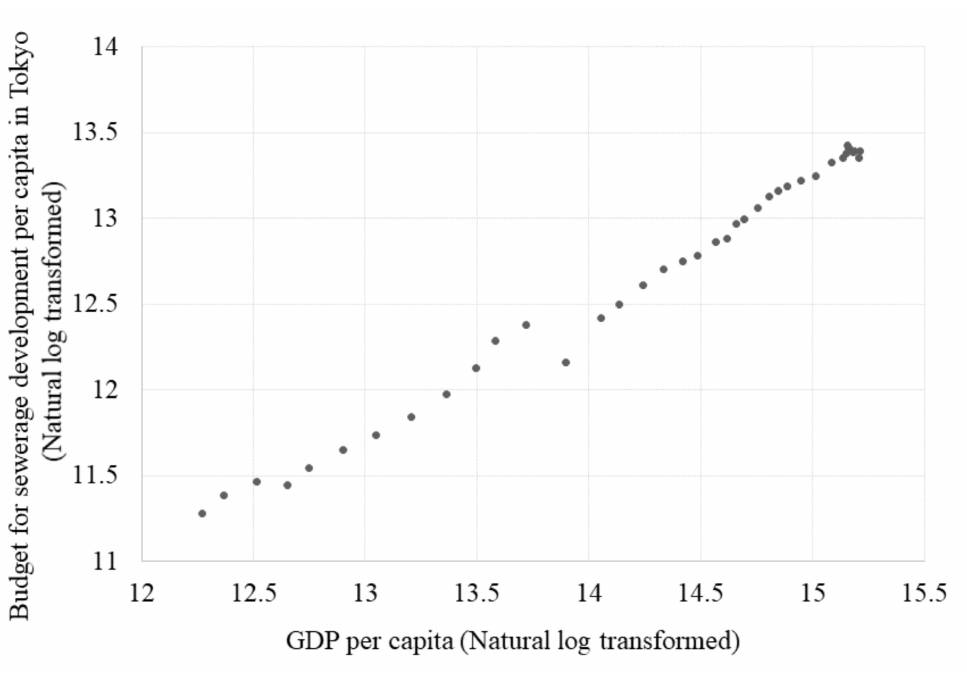
Figure 3. GDP per capita and the budget for sewerage development per capita in Tokyo. The graph was plotted using the data from 1961 to 1998 from the